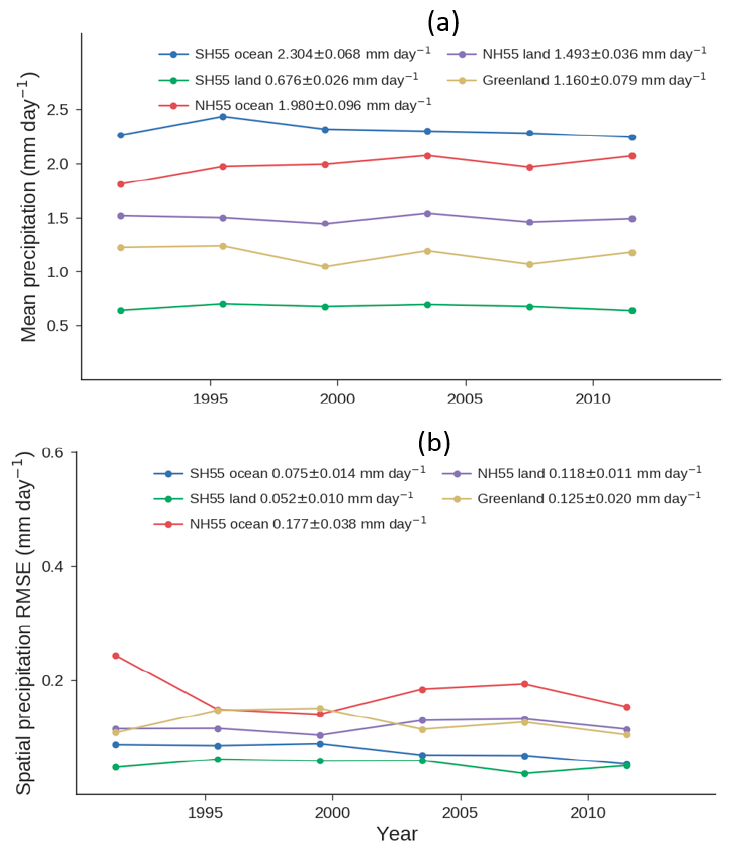
Figure 1. ( a ) mean 4-year average precipitation for each labelled region in GPCP and ( b ) mean 4-year RMSE compared with the 1990–2015 average in GPCP. The points are plotted at the center of each 4-year period.